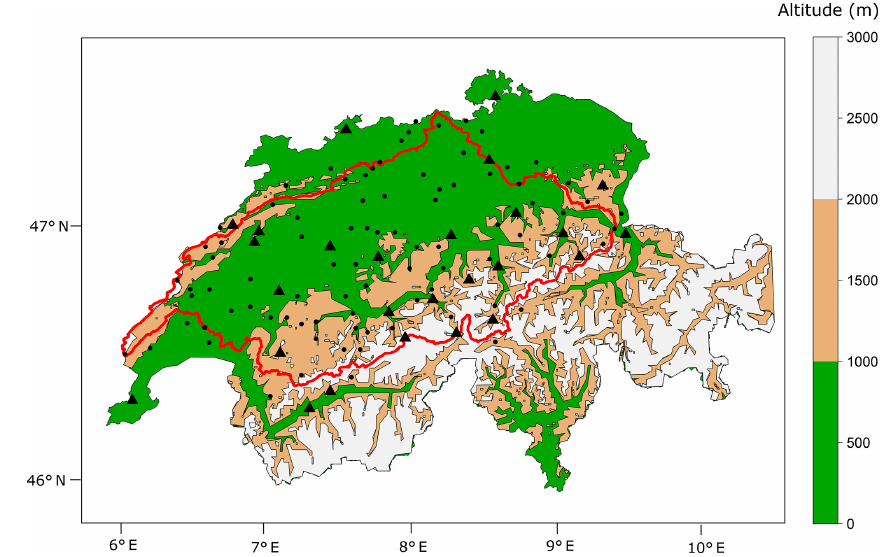
Figure 1. The Aare River basin (red) and locations of the different precipitation (dots) and temperature (triangles)